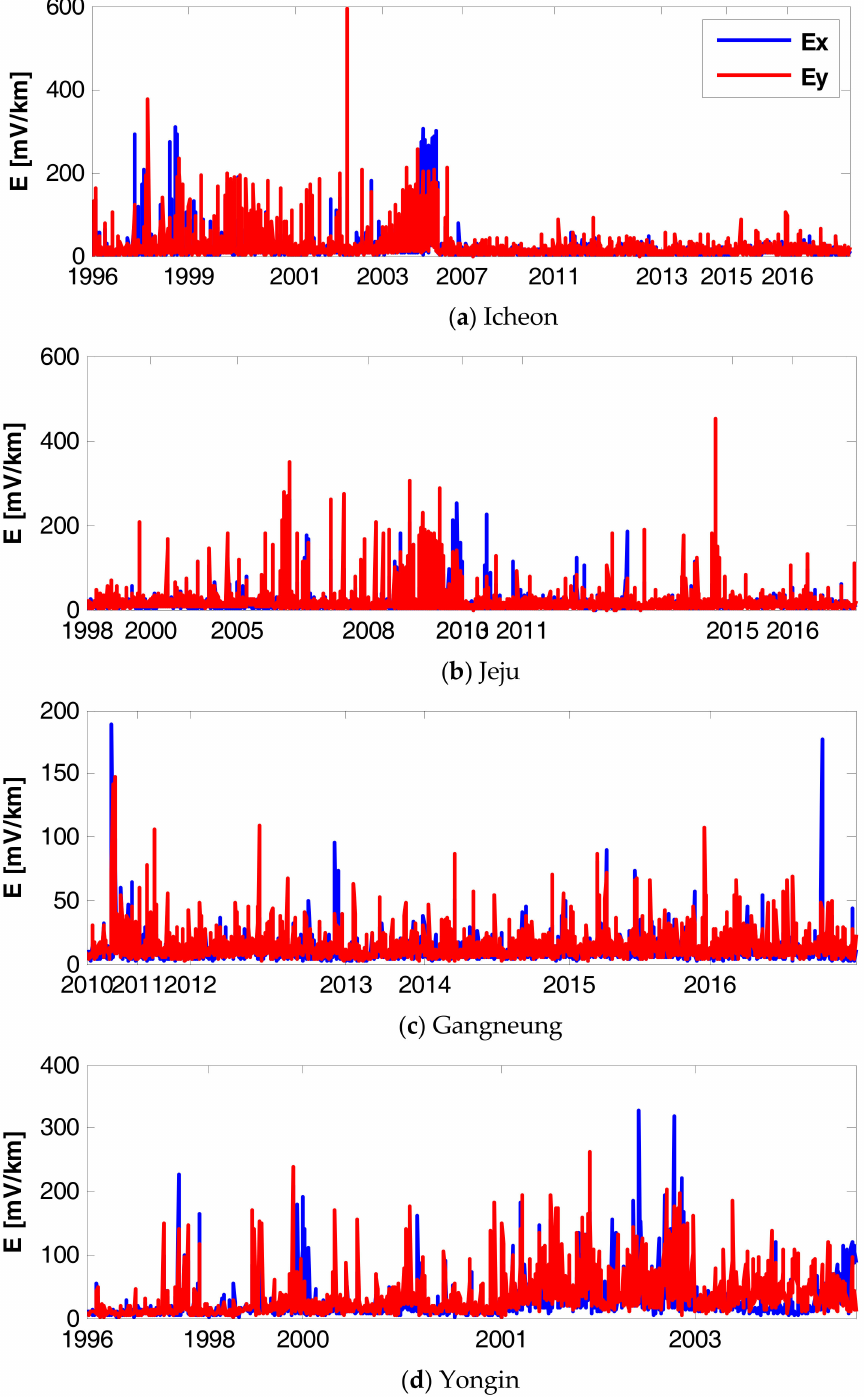
Figure 3. Daily maximum of geoelectric field ( Ex : Blue, Ey :